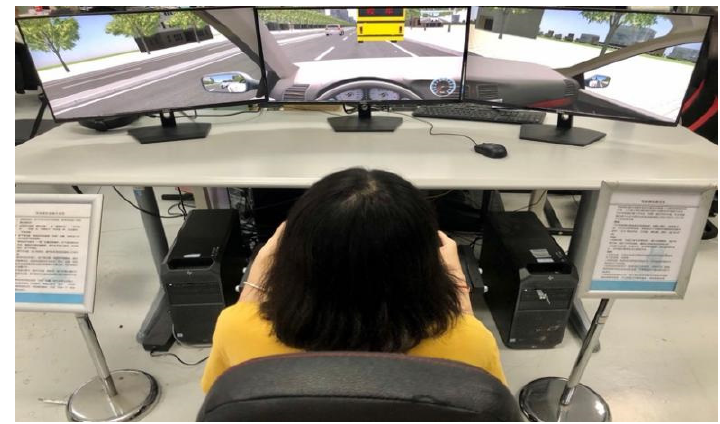
Figure 1. Driving simulator.